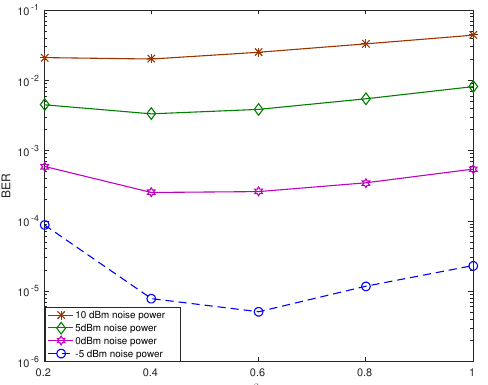
Figure 9. BER performance based on the ratio of the power between the pilot signal and the information in the superimposed